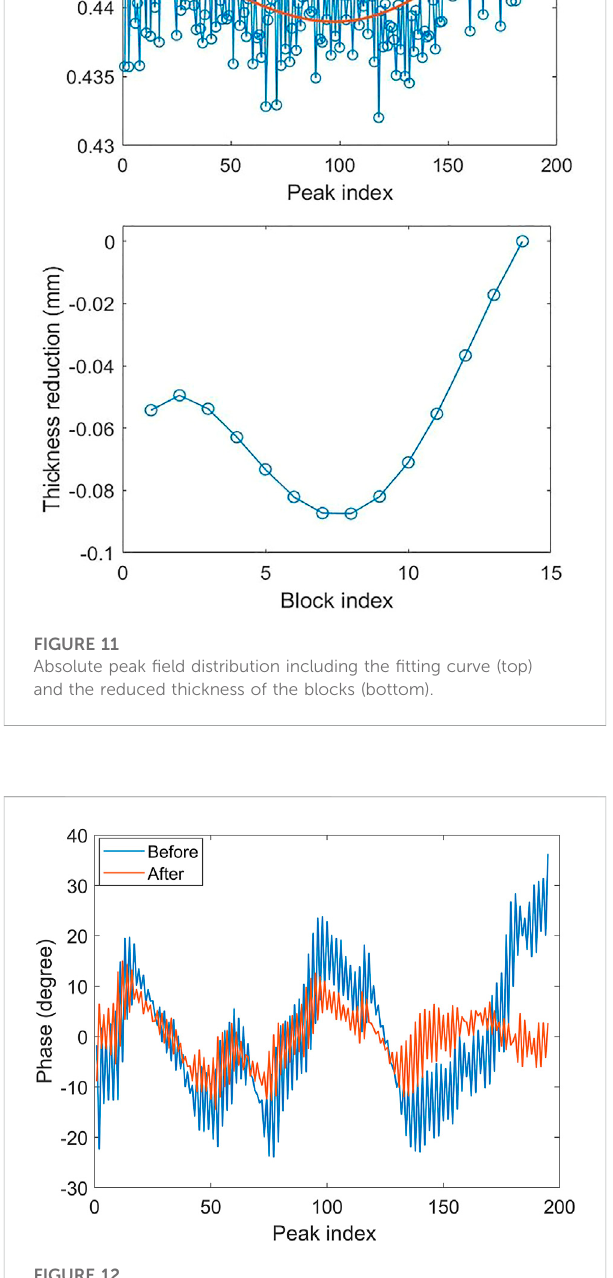
FIGURE 12 Phasemapsforthe1.5-m-longSCUat300Amaincurrentbefore and after the gap